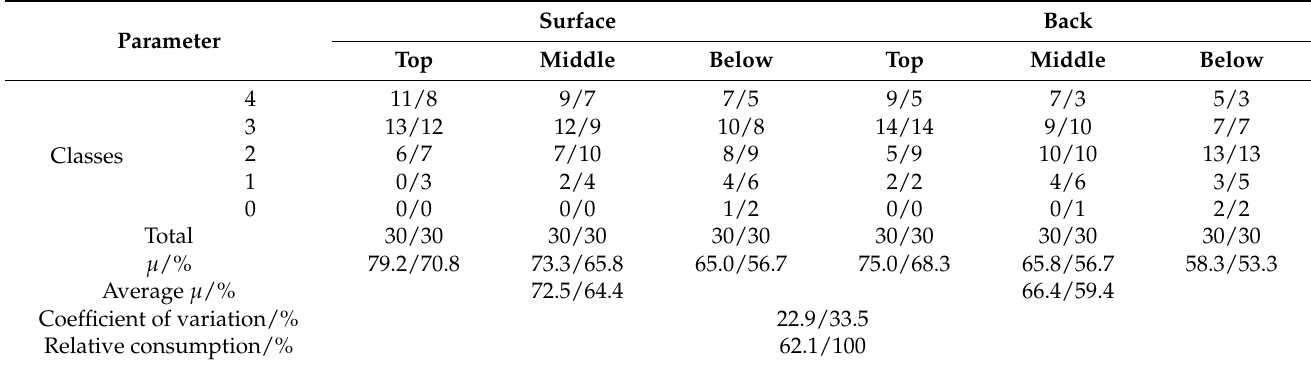
Table 5. Results of the determination of the adhesion